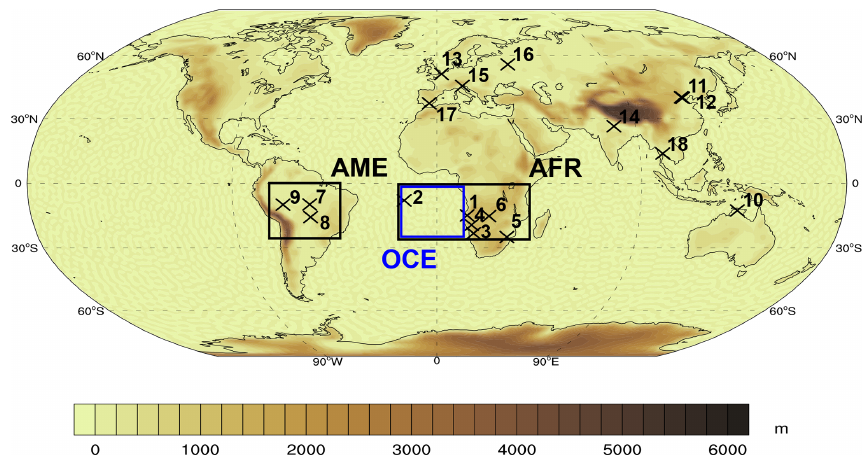
Figure 1. Orography (m) used in ARPEGE-Climat simulations. Locations of the Aerosol Robotic Network (AERONET) stations used in this study are shown (black crosses; see Table 1 for details on these AERONET stations), as the different regions used in this study, AME (70–20 ◦ W/0–25 ◦ S) and AFR (15 ◦ W–40 ◦ E/0–25 ◦ S, black boxes) and OCE (15 ◦ W–10 ◦ E/0–25 ◦ S, blue